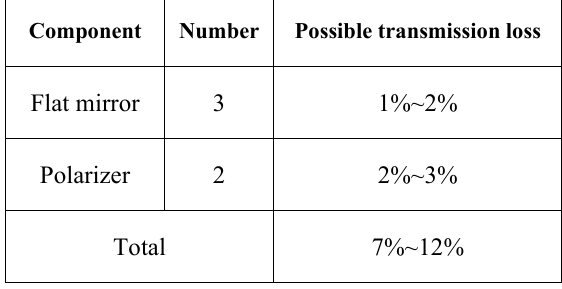
Fig. 2. Diagram of gyrotron operation platform.